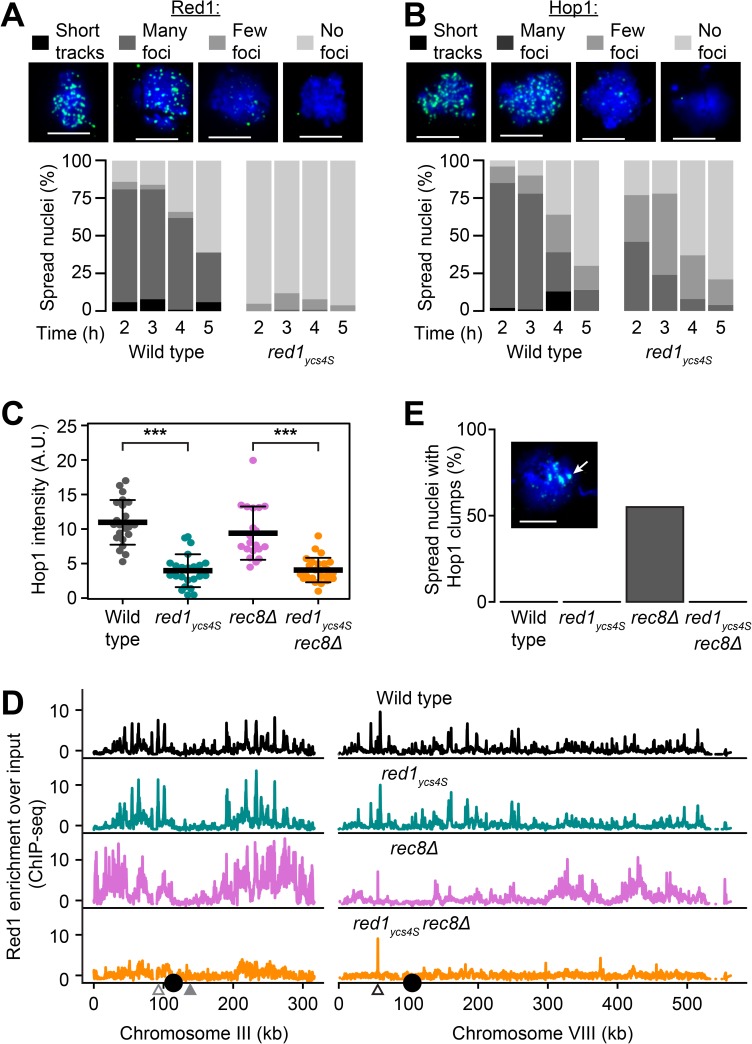
Decreased deposition but normal distribution of axis proteins in red1ycs4S mutants.(A) Red1 binding and (B) Hop1 binding was analyzed on chromosome spreads from wild-type (H7797) and red1ycs4S (H7011) strains, n = 100 per time point. Patterns were classified into four categories: “No foci”, “Few foci” (less than 20 detectable by eye over background), “Many foci”, or “Short Tracks” (indicative of chromosome axes). Scale bars are 5μm. (C) Hop1 intensity values of nuclei spread at 2h after meiotic induction. Focus intensity across an entire spread was normalized against background intensity of an area of identical size. Average intensity is indicated for wild-type (grey), red1ycs4S (cyan), rec8Δ (pink, H5187), and red1ycs4S
rec8Δ (orange, H7661) strains, n = 20. Error bars: S.D. ***: p-value < 10−5, Wilcox test. (D) Red1 chromosomal localization at 3h determined by ChIP-seq in wild-type (black, H119), red1ycs4S (H7011), rec8Δ (H7660 & H7772), and red1ycs4S
rec8Δ (H7661) strains on chromosomes III and VIII, n = 2. Large black circles indicate the positions of the centromeres. Triangles indicate positions analyzed by ChIP-qPCR in S3B Fig. (E) Percentage of spreads at 2h from time course in (C) exhibiting clumps of Hop1 (arrow in example image), n = 100.